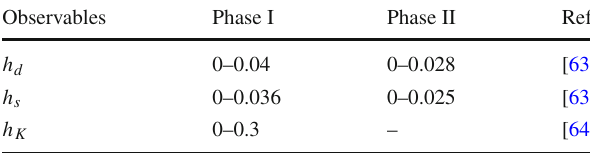
Table 7 Future projected sensitivity of the neutral meson mixing